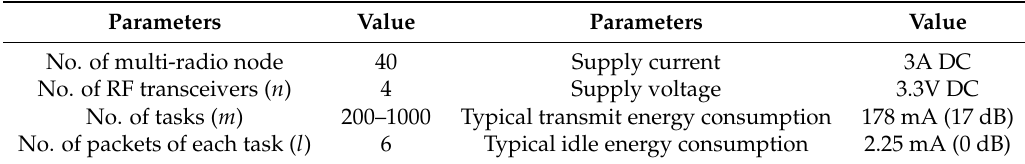
Table 2. Some key initialization